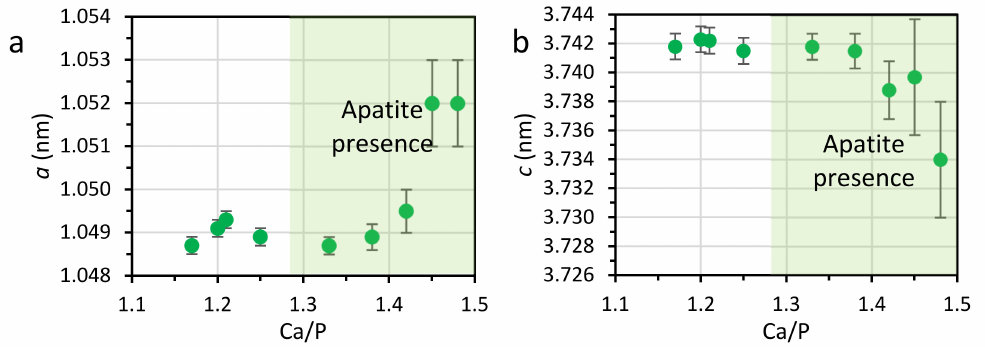
Figure 3. Dependence of the whitlockite lattice parameters a ( a ) and c ( b ) on the Ca/P